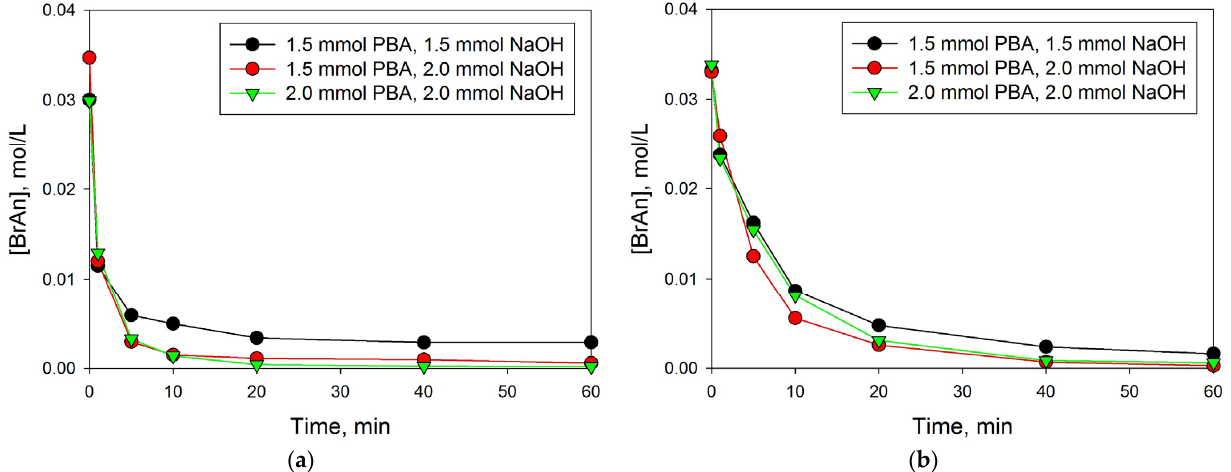
Figure 3. Influence of PBA-to-NaOH ratio on the activity of initial Pd(II)/HPS ( a ) and reduced Pd(0)/HPS ( b ) catalyst (0.47 mol.% Pd, 1 mmol BrAn, EtOH/H 2 O = 5:1, 60 °C, N 2 , 800 two-sided shaking/min).